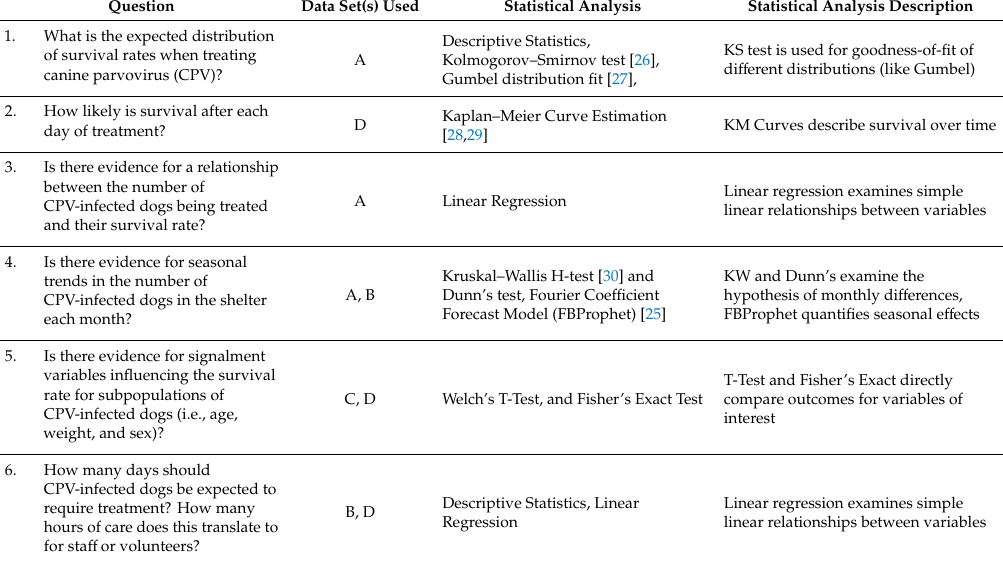
Table 2. Key questions, their associated data sets, and statistical methods employed. An explanation of what each test is used for is provided for